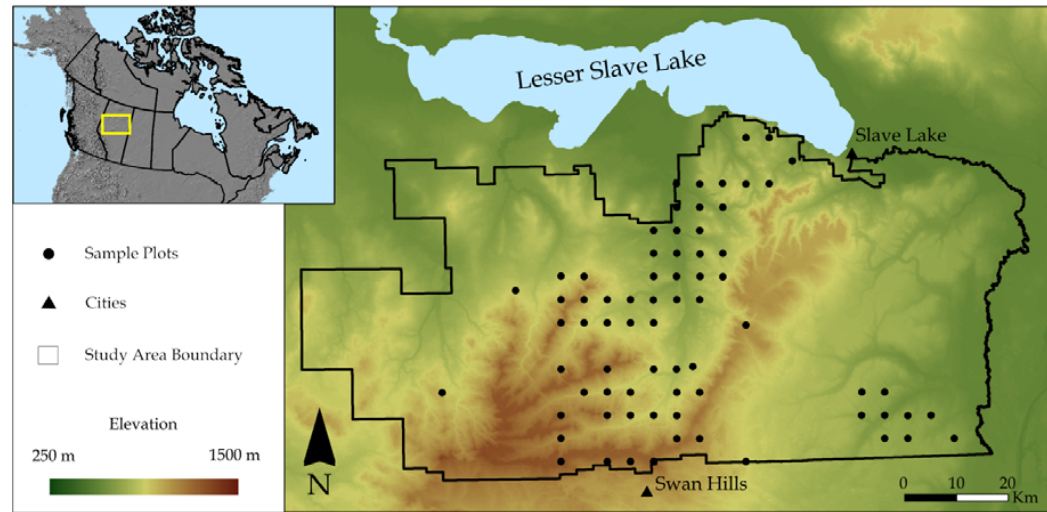
Figure 1. Map of the Slave Lake study area and sample plots ( n = 71).